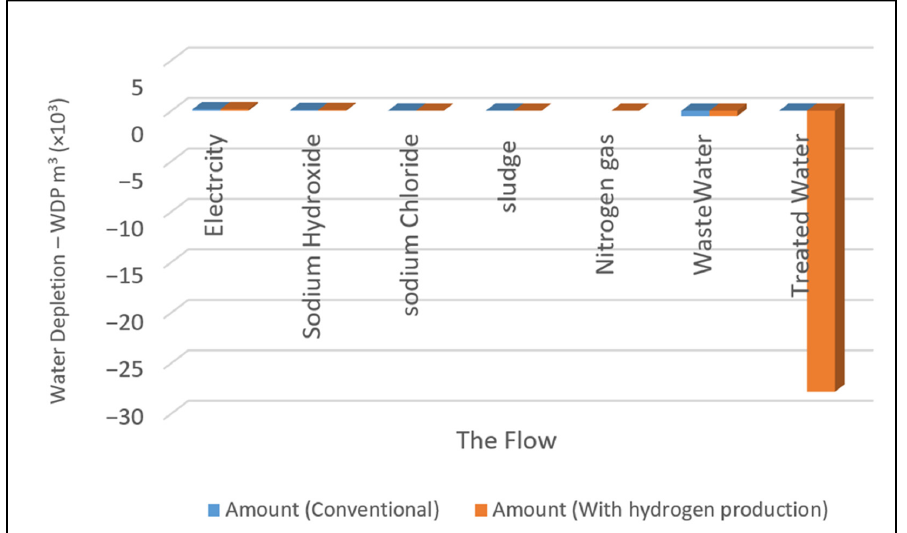
Figure 10. Main sources of water depletion.